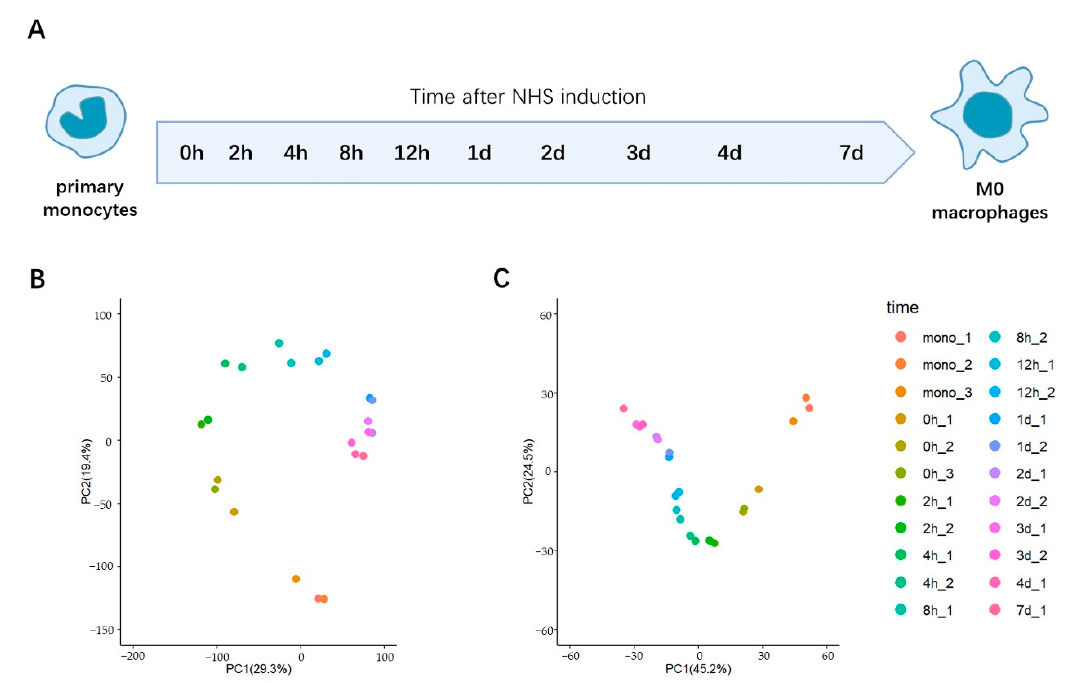
Figure 1. Temporal changes in the transcriptome during the trans-differentiation of monocytes to M0 macrophages. ( A ) Schematic diagram showing the examined time points during the transition. ( B ) PCA analysis of the whole transcriptome at the measured time points. ( C ) PCA analysis of the select, highly-expressed DEGs at the measured time points.